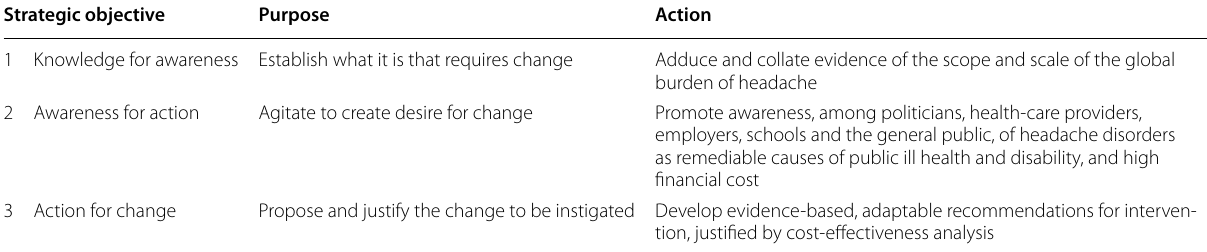
Table 1 The three strategic objectives of the Global Campaign Strategic objective Purpose